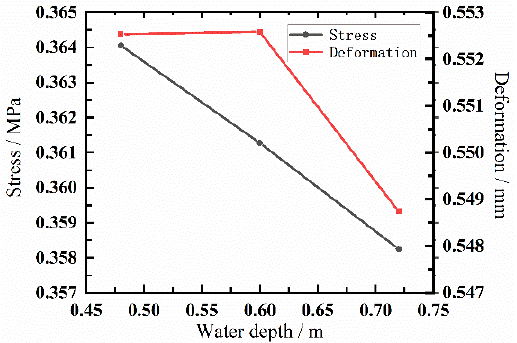
Figure 11. Stable cycle stress and deformation of the blade at different water depths.